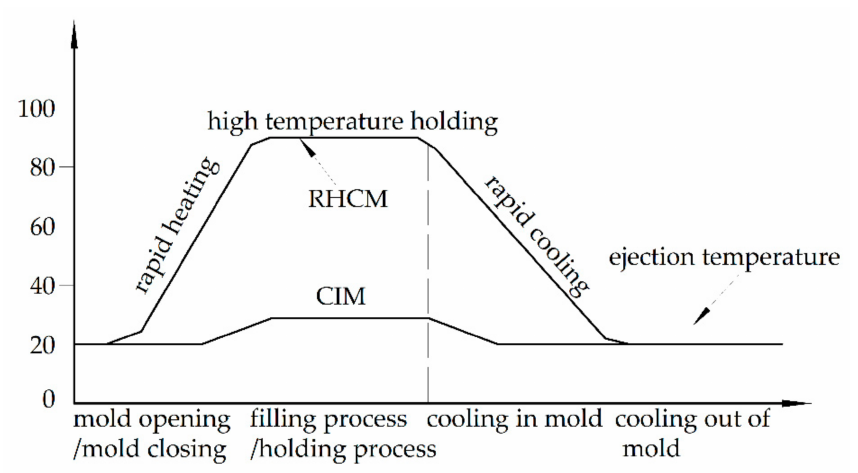
Figure 1. The RHCM